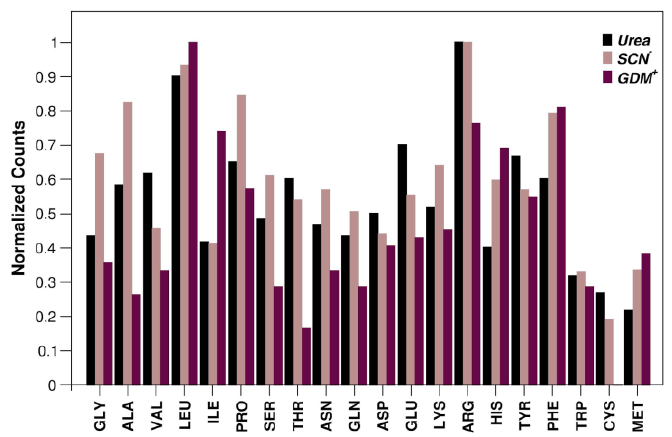
Figure 4. Representativeness of residue type involved in van der Waals-type interactions per urea, SCN − and Gdm + sites. Normalized values are given as the ratio of the observed value to the maximum value of the determined distribution. Data corresponding to SCN − are retrieved from reference [29]; distribution referred to Gdm + is generated using database of reference [28]. See also Figure S4.